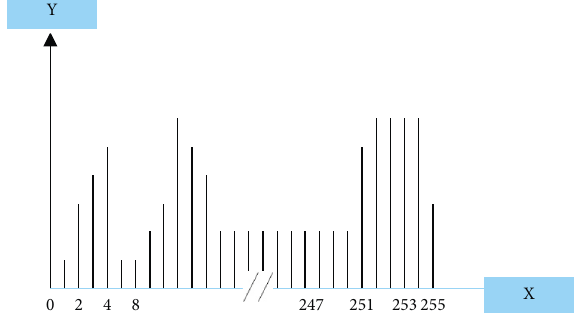
Figure 3: Image grayscale histogram.